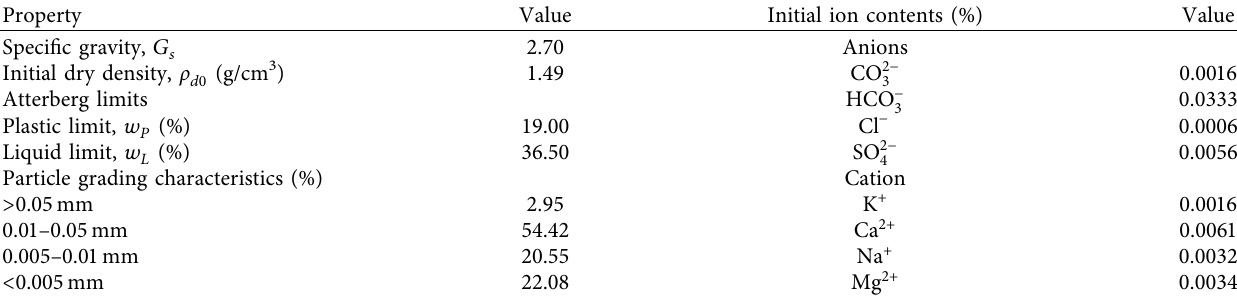
Table 1: Initial properties of the tested